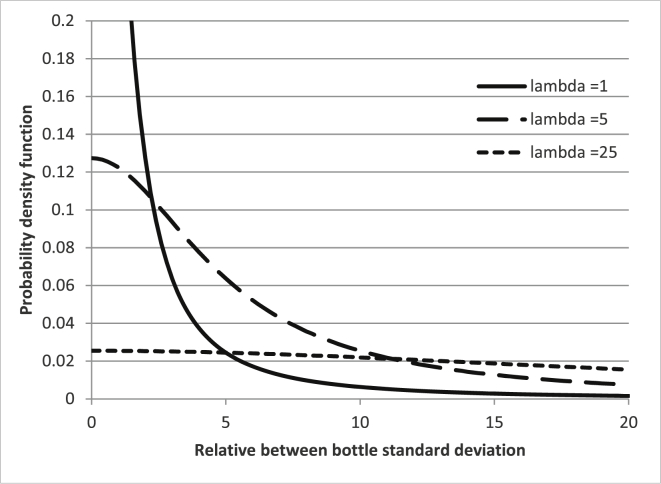
Probability density functions of half-Cauchy distributions with a scale parameter of 1 (solid line) 5 (dashed line) and 25 (dotted line).